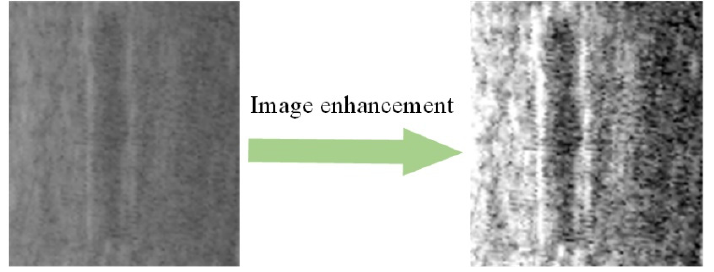
Figure 13. Using image gray enhancement algorithm to process the original image.